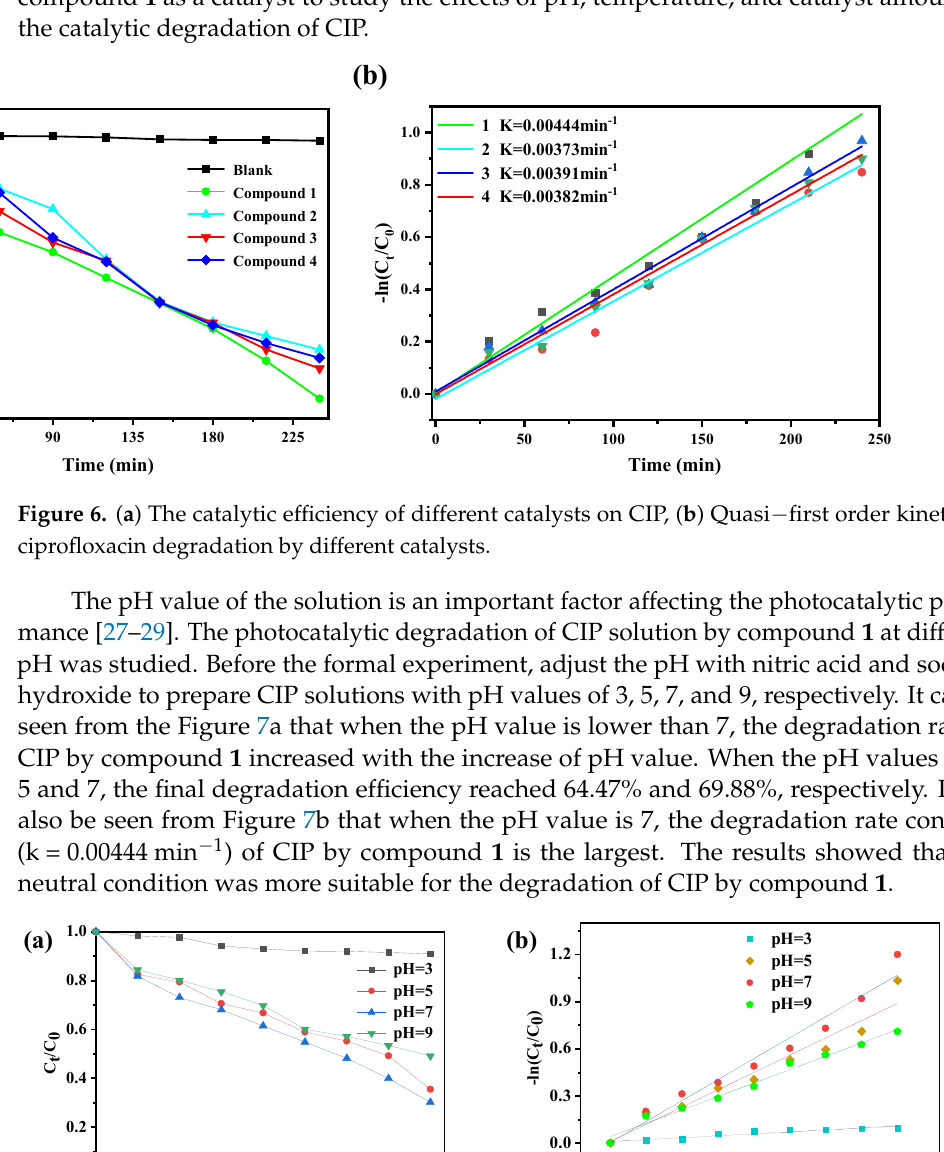
Figure 8. ( a ) Degradation rate of compound 1 to ciprofloxacin under different temperatures, ( b ) Quasi − first order kinetic reaction rate at different temperatures. In the degradation experiment, we also explored the influence of the amount of cat- alyst on the catalytic effect. CIP solution was placed under constant stirring conditions, and the degradation of CIP was studied by adding different doses of compound 1 . It can be seen from the Figure 9a that in the CIP/compound 1 system, when the amount of catalyst is from 5 mg to 20 mg, the degradation efficiency of CIP first increases and then decreases. The reason for this state is that the aggregation of excess compound 1 parti- cles hinder and inhibit the scattering and transmission of light in the solution, while the organics adsorbed on the photocatalyst will reduce the utilization of light [33–35]. After adding different doses of compound 1 , the final degradation rates reached 81.13%, 86.95%, and 69.97%, respectively. It can also be seen from Figure 9b that among the three doses, when the amount of compound 1 is 10 mg, the degradation rate of CIP is the highest.